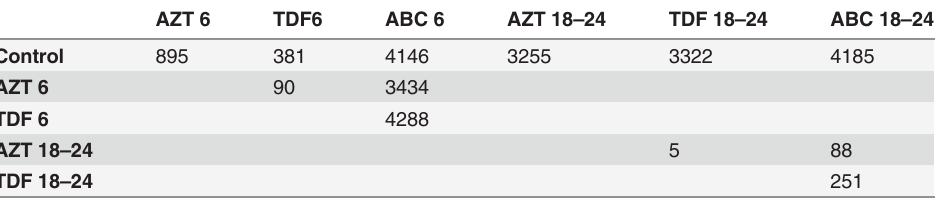
Table 1. Differentially expressed sequences between groups at 6 months and 18 – 24